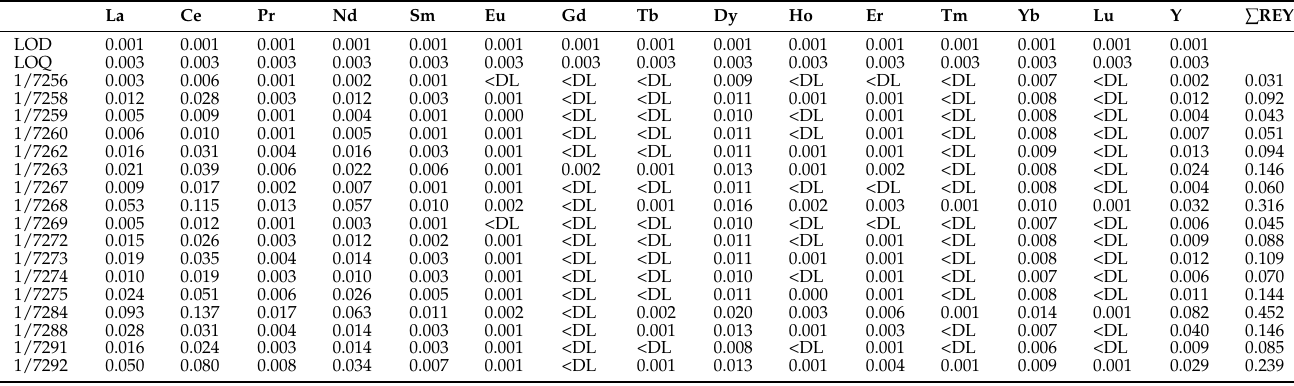
Table 3. Concentration of REY (in mg kg − 1 , dry matter) in the investigated mushrooms, including calculated LODs and LOQs (in mg kg − 1 ), minimum (min), maximum (max), and average (avg) values.